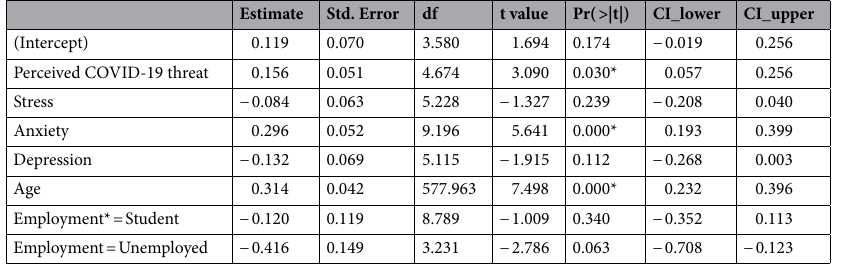
Table 2. Model 2 estimates (DV: Everyday altruism, SRA). *Reference class = Employed.